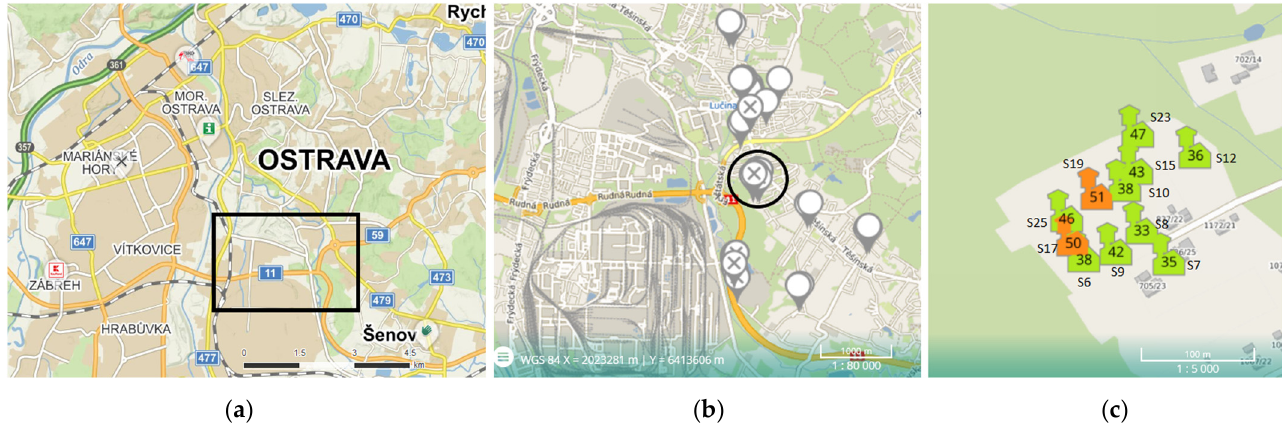
Figure 1. Sensor network location: ( a ) monitored area within the city of Ostrava; ( b ) overview of the city quarters and the deployed sensor network; and ( c ) detail of the evaluated cluster of sensor units, their identification, and visualization of measured values.